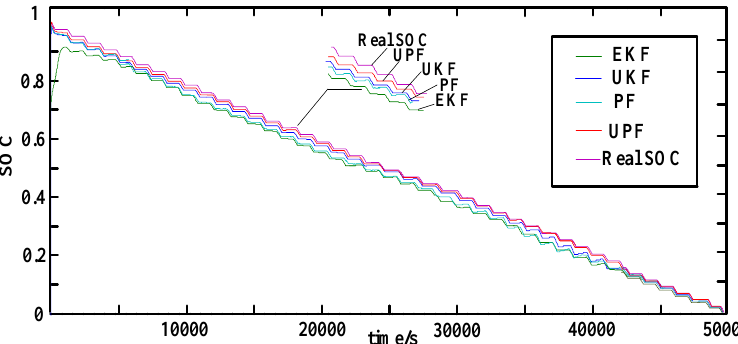
Figure 16. SOC estimation curves of di ff erent algorithms under open-circuit voltage disturbances.